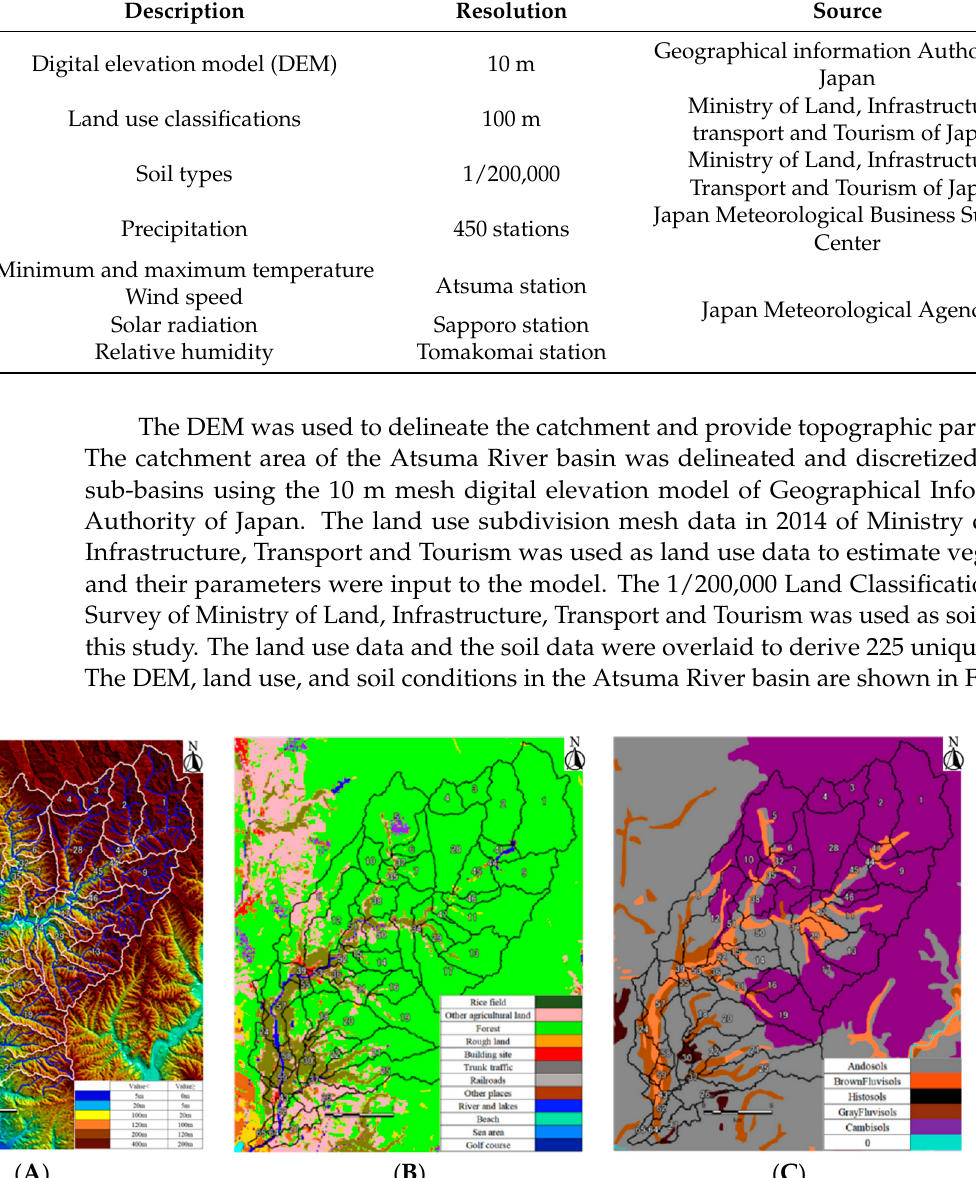
2015 to 2019, but there was a period when no data was collected from 20 July 2017 to 30 September 2017. The outflow data at the Atsuma dam is from 1 January 2015 to 5 Septem- ber 2018, but there was a period where no data was collected after 2017. The inflow and outflow data at Apporo dam was from 10 August 2018 to 10 November 2018, and from 20 March 2019 to 25 June 2019. 2.2.3. Parameters of SWAT Model The SWAT model itself had the function of generating default parameters according to the soil data, land use data, and elevation data of the study area. Researchers could also adjust the parameters by historical hydrological data or the SWAT-CUP software. This study uses the SWAT-CUP software to analyze the runoff parameter sensitivity and to modify parameters accordingly. Firstly, sensitivity analysis was performed to identify the most sensitive runoff parameters for the model calibration using the Global Sensitivity part of SWAT-CUP. Determining the most sensitive parameters for reproducing runoff were Snow pack temperature lag factor (TIMP), Curve number (CN2), Melt factor for snow on 21 December (SMFMN), Melt factor for snow on 21 June (SMFMX), Temperature lapse rate (TLAPS), Available water capacity (SOL_AWC), Snow melt base temperature (SMTMP), Effective hydraulic conductivity in main and tributary channel alluvium (CH_K2, CH_K1), Minimum snow water content that corresponds to 100% snow (SNOCOVMX), Manning’s “n” value for the main and tributary channel (CH_N2, CH_N1), Soil evaporation compensation factor (ESCO), Precipitation lapse rate (PLAPS), and Snowfall temperature (SFTMP). Next, the sensitive runoff parameters were automat- ically calibrated using the Sequential Uncertainty Fitting (SUFI-2) algorithm, and the cor- rected runoff parameters were obtained. Regarding sediment parameters, because this study does not have measured sediment transport data, SWAT-CUP cannot be used for sensitivity analysis and correction of sediment parameters. According to previous re- search, field investigation, the correlation between sediment transport with turbidity and multiple simulation attempts, the sediment transport parameters after earthquake were chosen and corrected manually. The SWAT model was run daily for 11 years, the warm up period is from 2009 to 2014, the period from 2015 to 2017 was used for the calibration and the period from 2018 to 2019 was used for the validation. Table 2 shows the parame- ters in the Atsuma River basin.